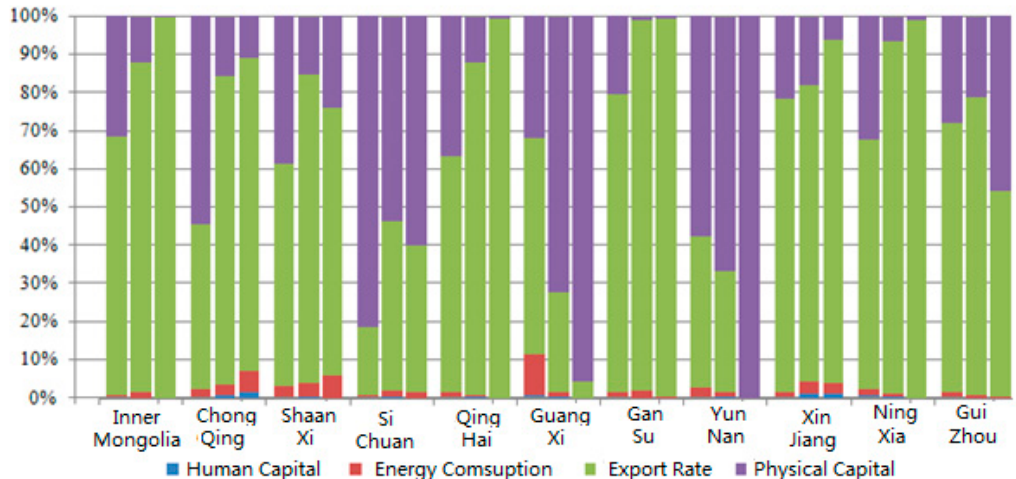
Figure 8. Variables contribution of FDI performance in the west region.